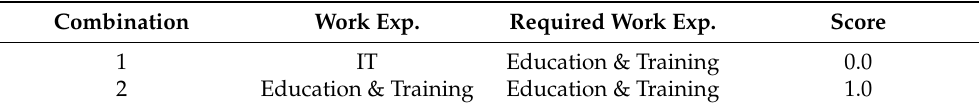
Table 6. Work Experience